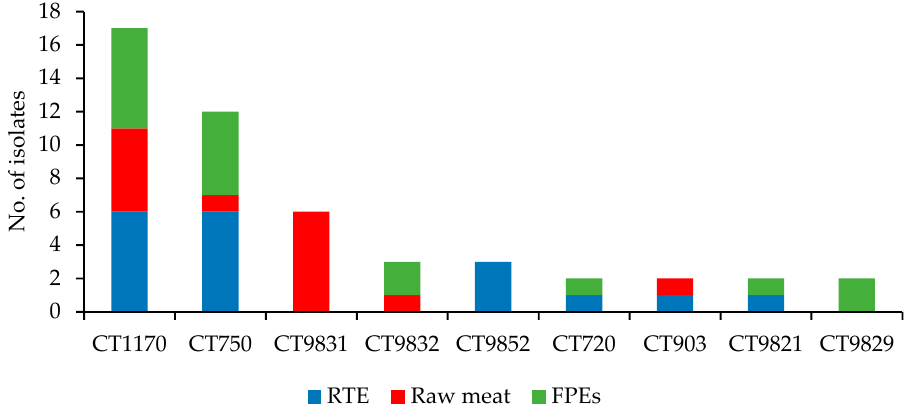
Figure 3. Distribution of cgMLST types (CTs) among of 100 L. monocytogenes isolates tested, which were identified in more than one isolate.